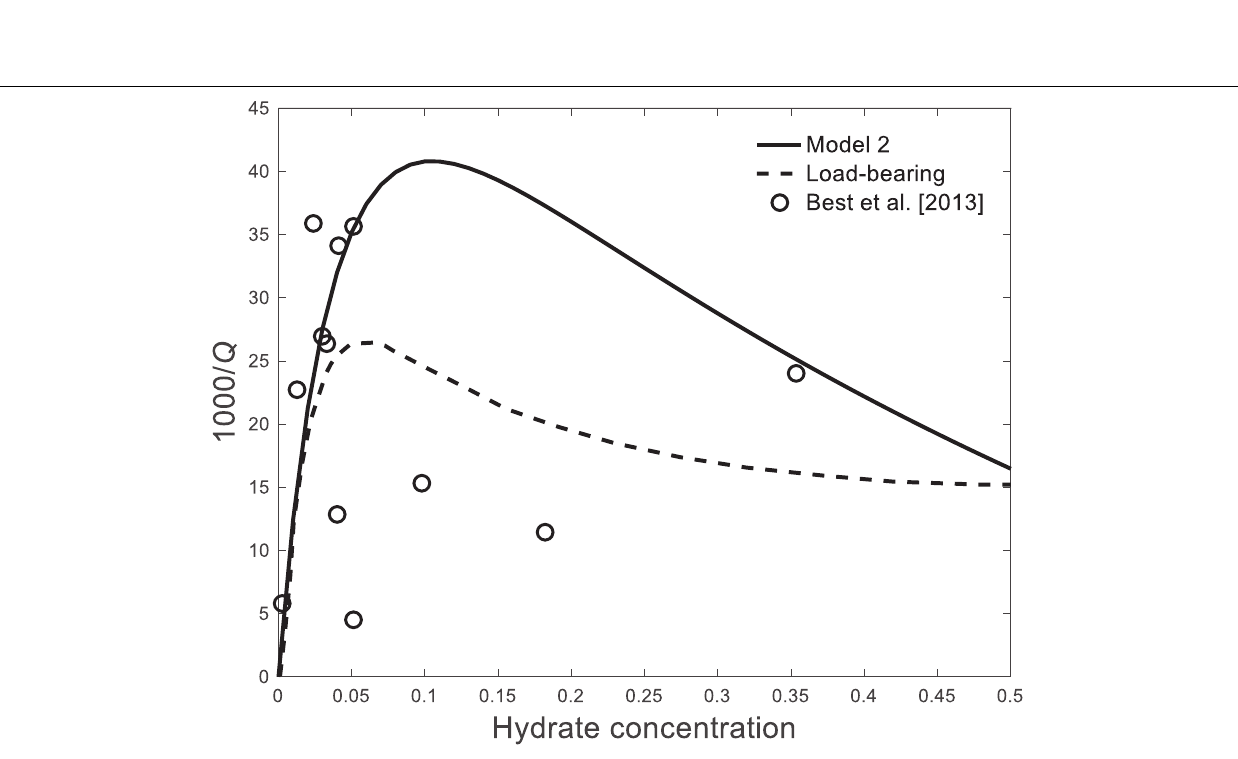
Frontiers in Earth Science |